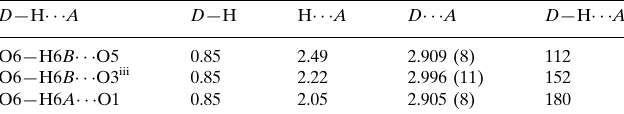
Hydrogen-bond geometry (A˚ , (cid:4)